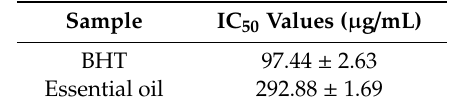
Table 1. Scavenging activity of DPPH radical of the essential oil.